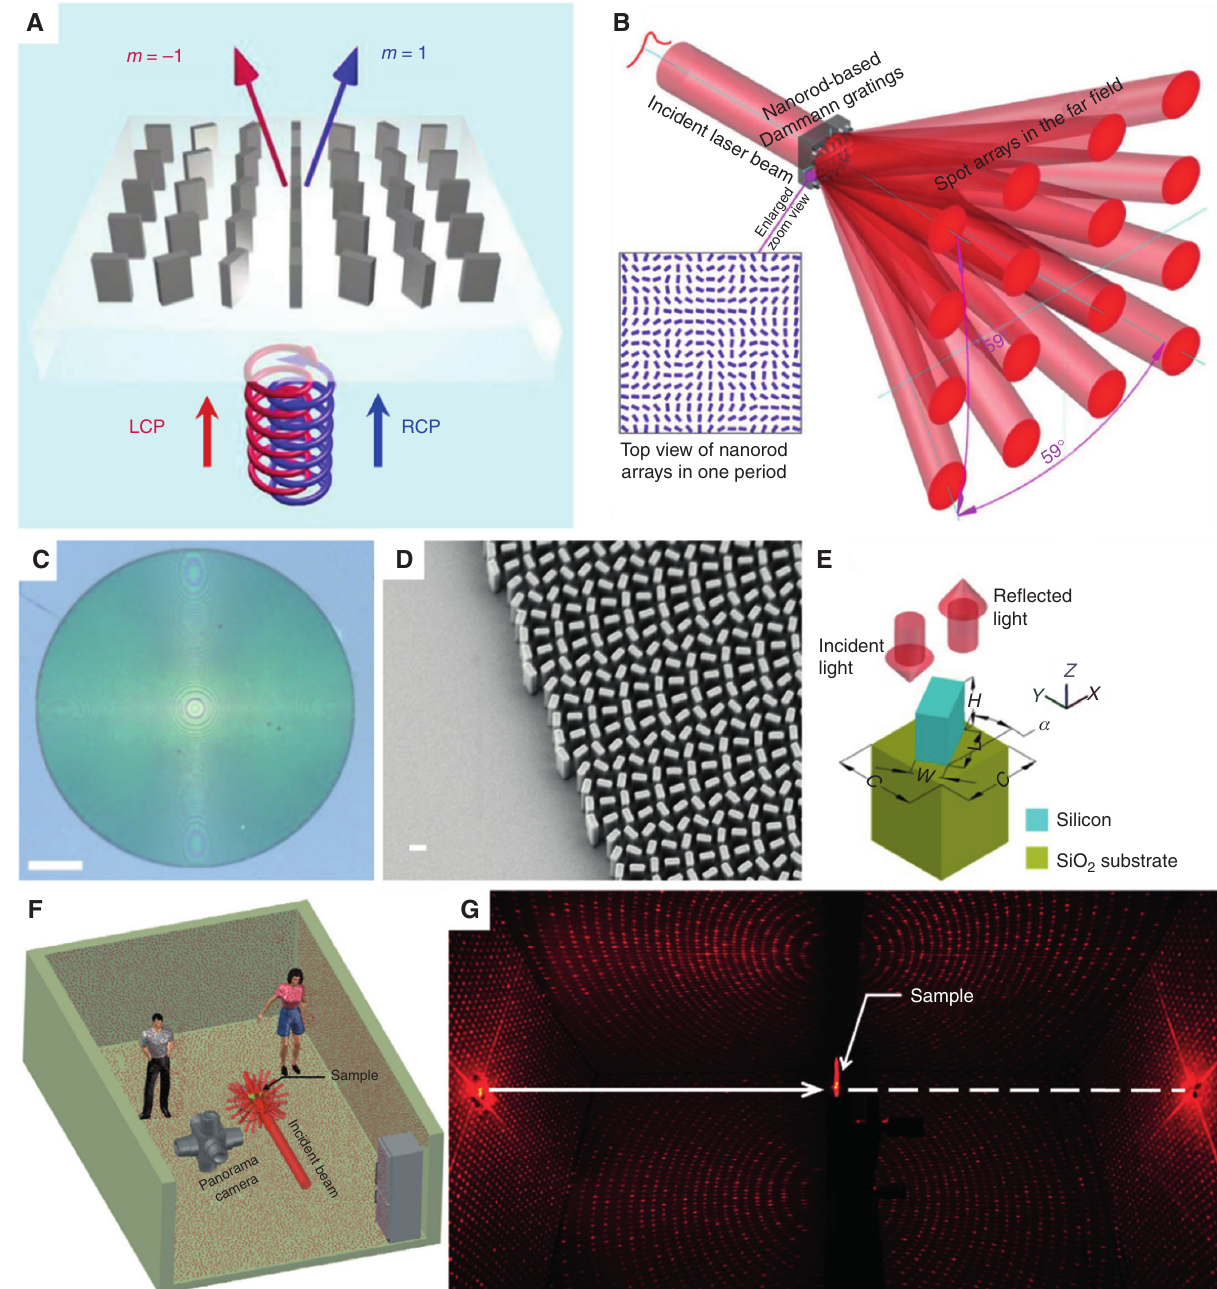
Figure 8: Illustration of geometric metasurfaces based on dielectric nanostructures. (A) Helicity-dependent dielectric metagrating [70]. (B) 4 × 4 all-silicon beam splitter (Dammann grating) [71]. (C and D) Metalens with large NA based on TiO nanofins [72]. (E) Unit cell of a dielectric metasurface based on Mie resonance [73]. (F and G) Random point cloud 2 generator working in 4 π space based on resonant dielectric metasurfaces [74]. Reprint permission obtained from